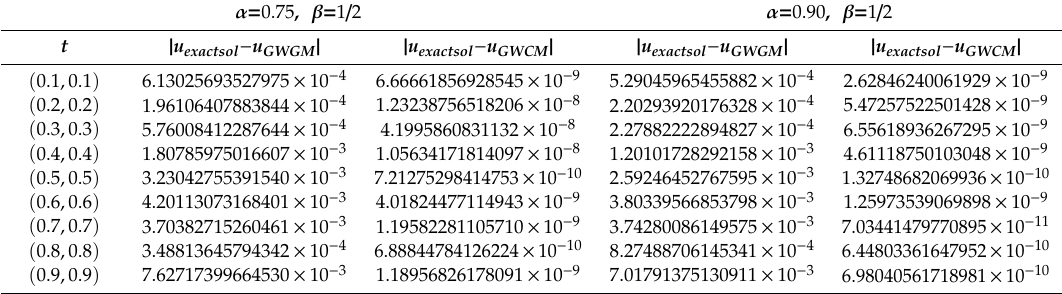
Table 3. Absolute errors of the approximate solutions obtained using the Gegenbauer wavelet collocation method and the Gegenbauer wavelet Galerkin Method at various points of x and t for β = 0.5.